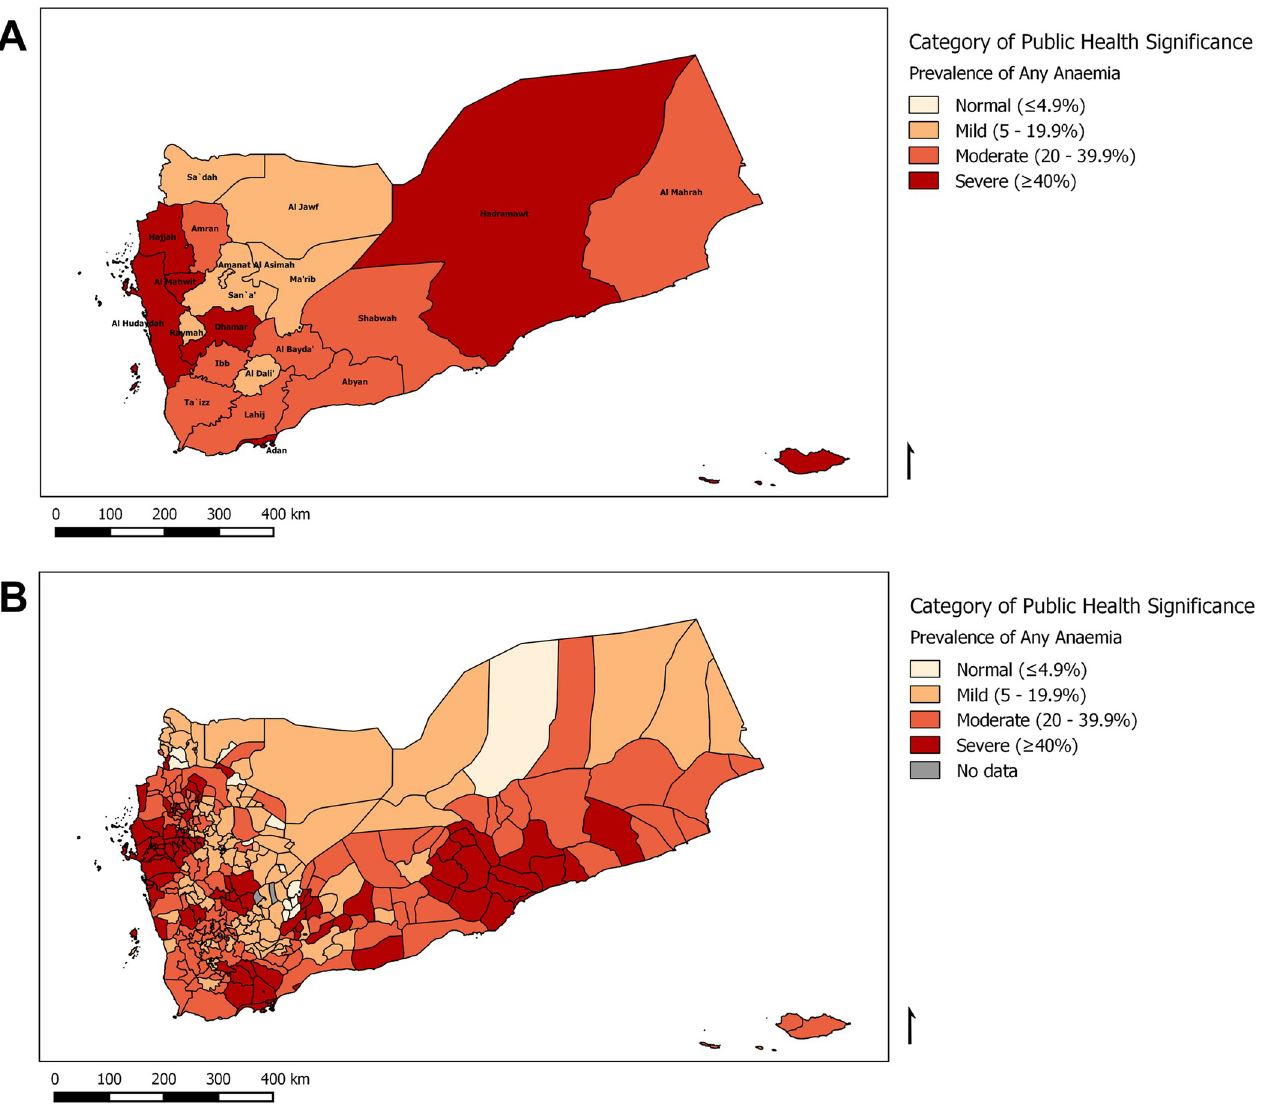
Fig 4. Prevalence maps of the public health significance of anaemia in Yemen, 2014. The maps display anaemia severity nationwide at (A) the governorate level and (B) the district level. These figures were created for this manuscript in QGIS using open-source data from DIVA-GIS for the base layers. (DIVA-GIS- http://www.diva-gis.org/gdata).